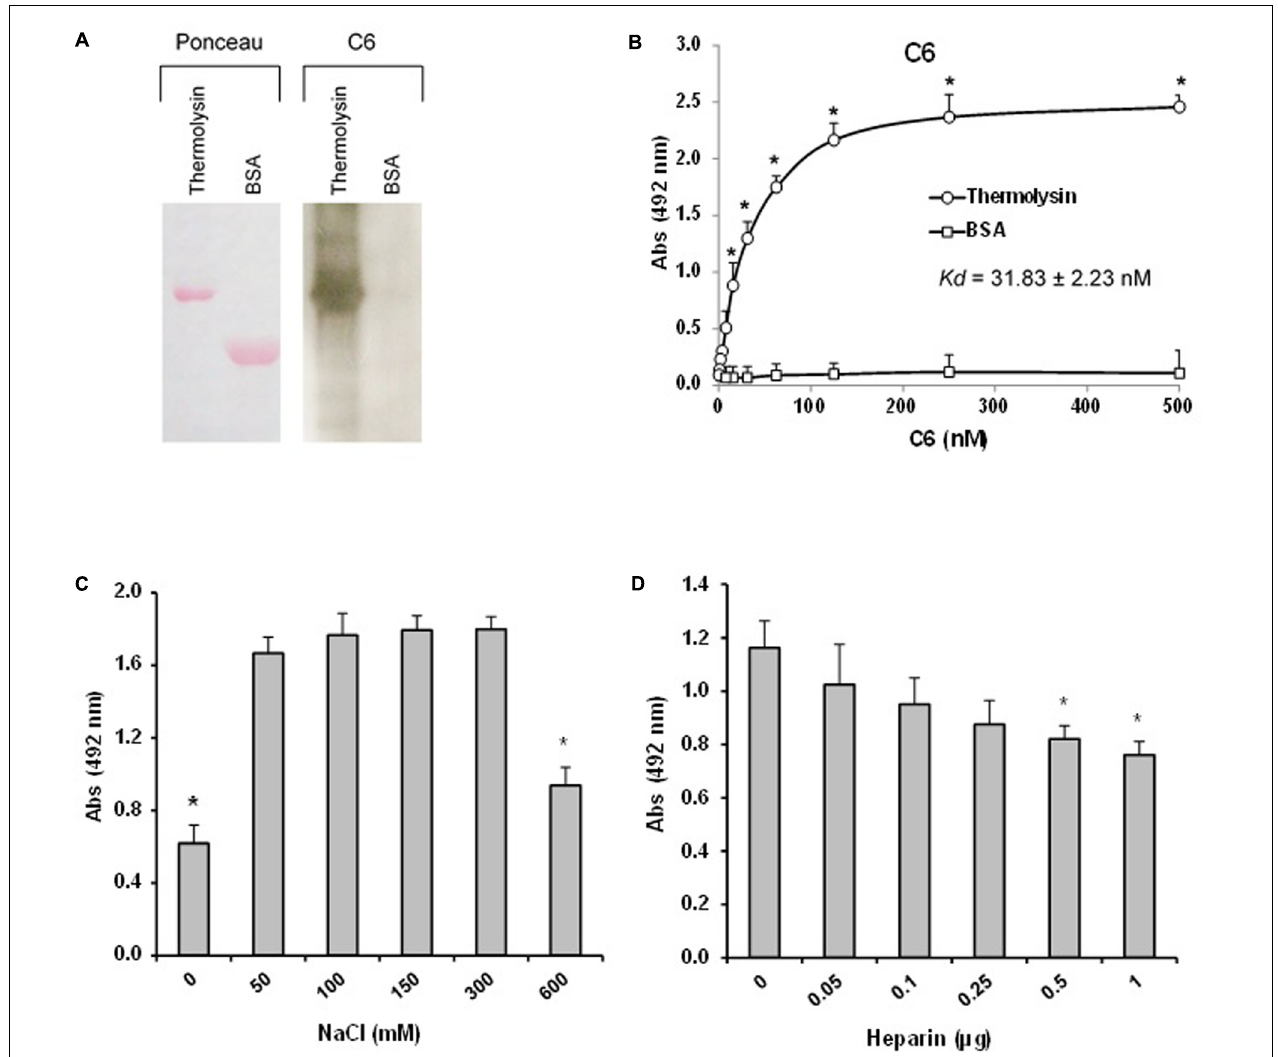
FIGURE 10 | The leptospiral thermolysin interacts with C6. (A) Affinity blotting. (Left) Recombinant Thermolysin and BSA were subjected to 12% SDS–PAGE under non-reducing conditions, transferred to a nitrocellulose membrane, and stained with Ponceau S. (Right) The membrane containing the immobilized proteins was incubated with purified C6, and binding was detected with anti-human C6 polyclonal antibody. (B) Microtiter plates were coated with Thermolysin (1 µ g) and different amounts of C6 were added. Binding was detected with anti-human C6 polyclonal antibody. BSA was included as a negative control. Each point represents the mean absorbance value at 492 nm ± SD of three independent experiments, each performed in duplicate. Binding of C6 to Thermolysin was compared with the binding of this molecules to BSA by the two-tailed t -test ( ∗ p < 0.05). The dissociation constant ( K d ) of the interactions was calculated by fitting the data to the equation Y = B max ∗ X/(K d + X) using GraphPad Prism 5.0 (GraphPad Software, Inc.). (C) Interaction of Thermolysin with C6 is dependent on ionic strength. C6 (1 µ g) diluted in different NaCl concentrations (0–600 mM) were added to Thermolysin immobilized on microtiter wells. Binding was detected with anti-human C6 polyclonal antibody. (D) Interaction of thermolysin with C6 is affected by heparin. C6 (1 µ g) diluted in different heparin solutions (0–1 µ g) were added to thermolysin immobilized on microtiter wells. Each point represents the mean absorbance value at 492 nm ± SD of three independent experiments, each performed in duplicate. Data were analyzed using ANOVA test ( ∗ p <